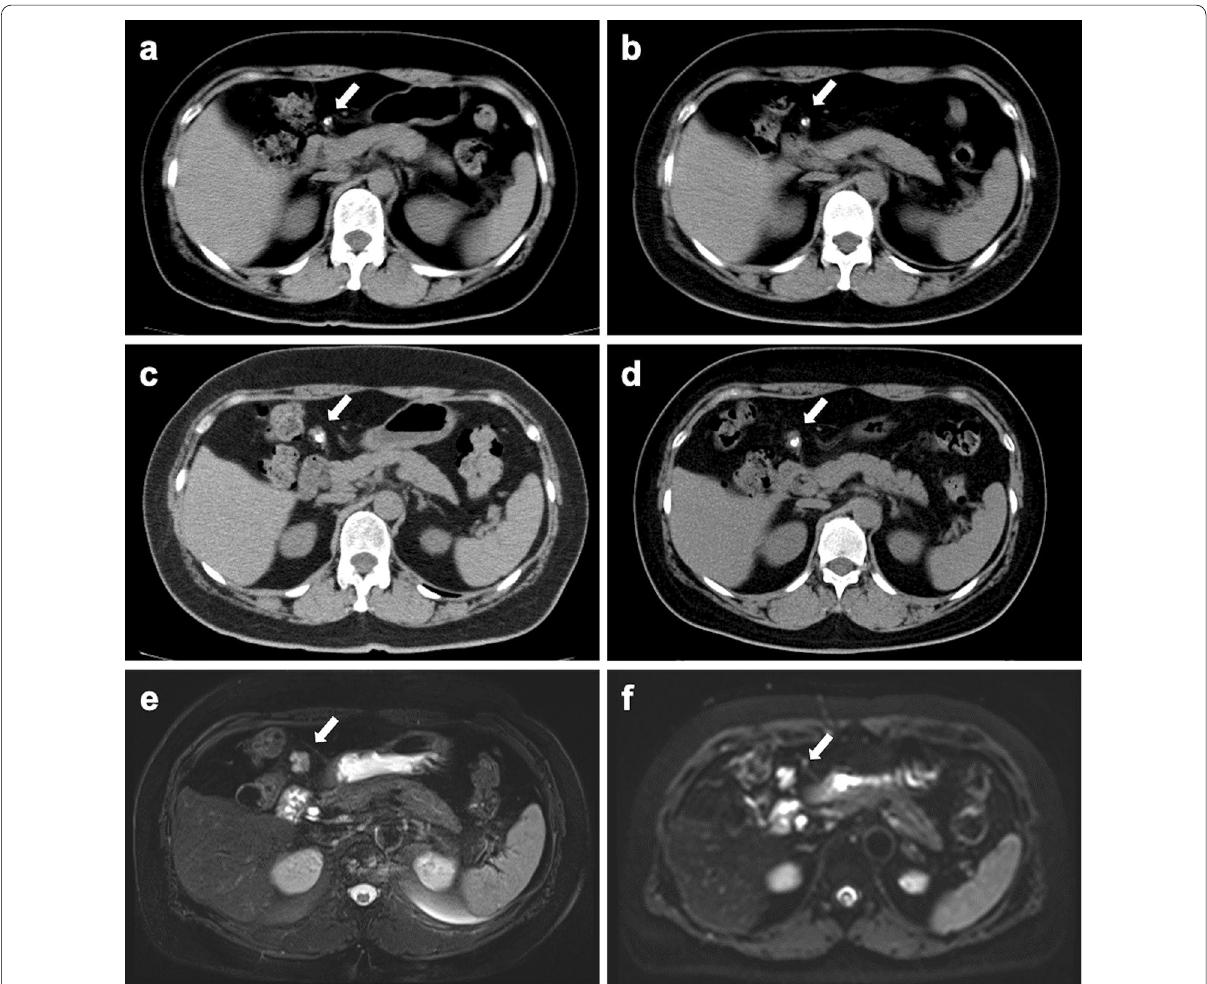
Fig. 1 Computed tomography and magnetic resonance images. a – d Computed tomography revealed a gradually growing tumor. e T2-weighted magnetic resonance image showed a faint high-signal-intensity tumor. f Diffusion-weighted magnetic resonance image showed that tumor was high-signal